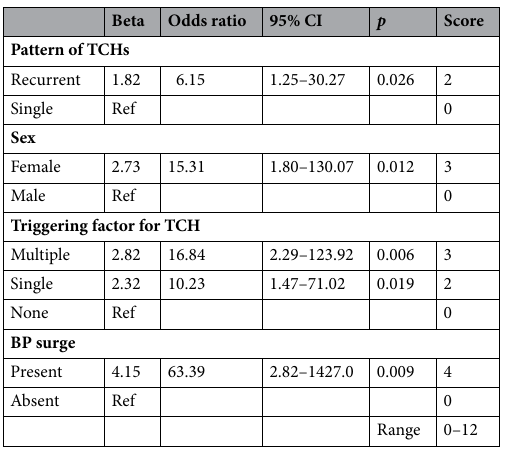
Table 2. Multivariable logistic regression analysis of clinical factors associated with diagnosis of RCVS and RCVS–TCH score.